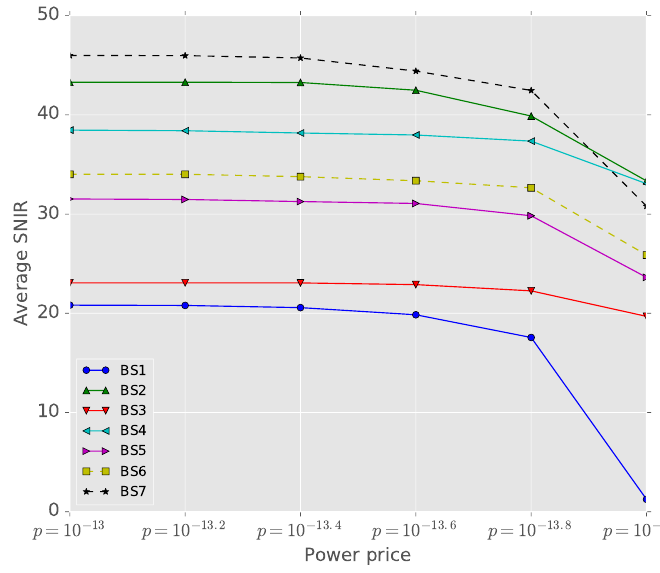
Figure 7. Average SNIR of all cluster heads for different power prices.